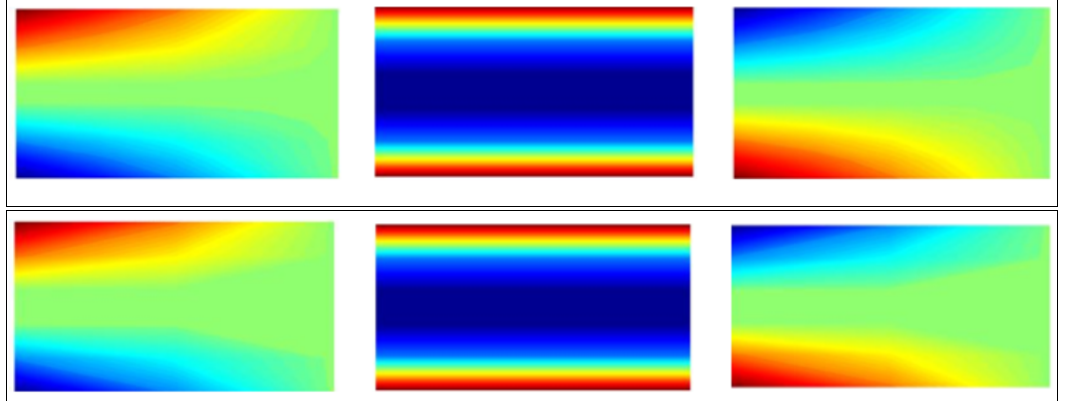
Figure 4. Beam solution (Top figure: Reconstructed solution ε xx , ε xy , ε yy and lower figure: True solution ε xx , ε xy , ε yy